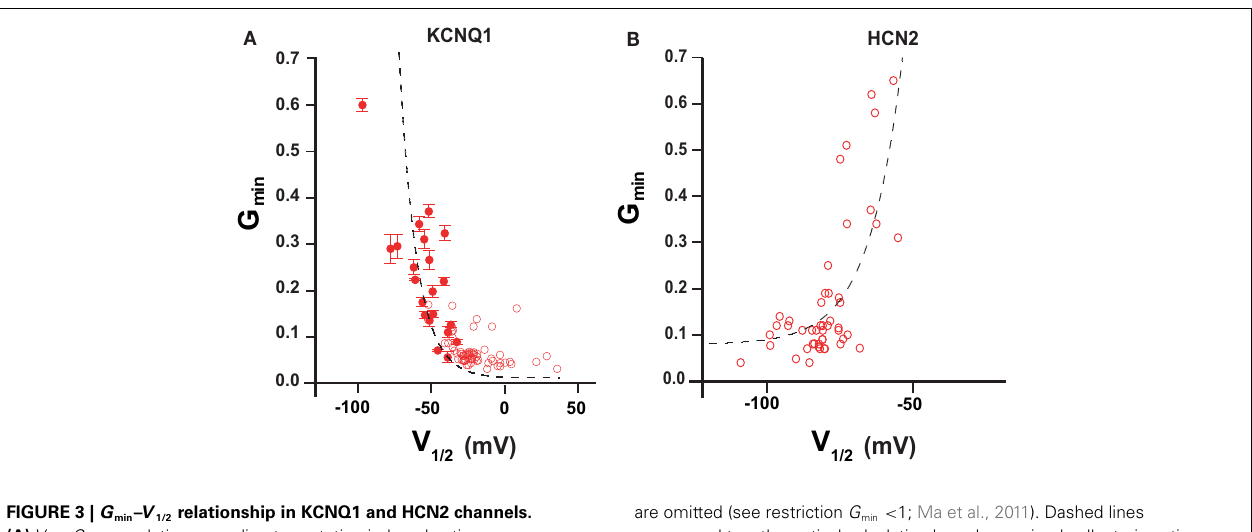
FIGURE 3 | G min – V 1/2 relationship in KCNQ1 and HCN2 channels. (A) V 1/2 – G min correlation according to mutation-induced gating perturbations analysis of KCNQ1 (Ma et al., 2011) (B) V 1/2 – G min correlation for HCN2 channel calculated from published studies (Chen et al., 2001; Decher et al., 2004). Mutant channels showing G min values larger than 0.7